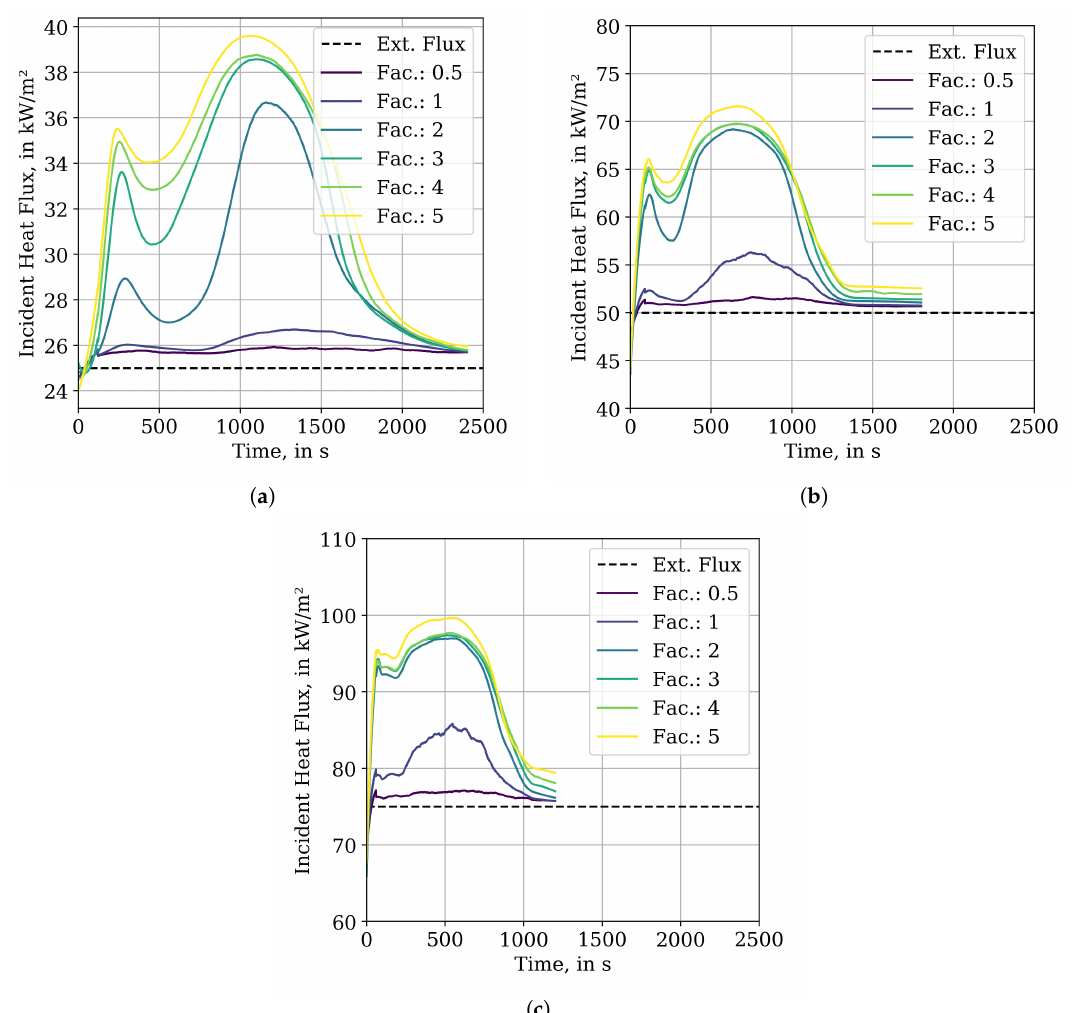
Figure A10. Different INCIDENT_HEAT_FLUX responses for material parameter set of T b in Cone Calorimeter simulations with different cell sizes. Cell sizes based on SCC (47mm) and are changed by dividing through the noted factor. Noise reduction by Savitzky-Golay, 2nd order polynomial, window length about 10 % of the amount of data points. ( a ) Experimental condition: 25kW/m 2 . ( b ) Experimental condition: 50kW/m 2 . ( c ) Experimental condition: 75kW/m 2 .